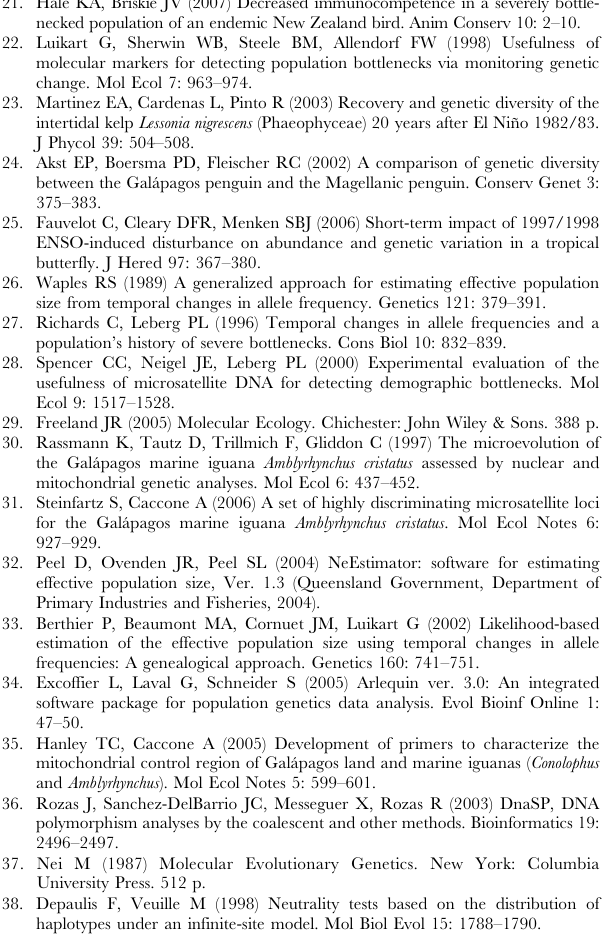
Table S4 List of nucleotide diversity ( p ) values and their variance (V) for marine iguana populations. List of nucleotide diversity ( p ) values and their variance (V) for marine iguana populations from both time points. T-values and their corre- sponding probabilities are based on the test adapted by Nei [37] and reflect whether p values are significantly different between time points. Positive t values reflect a decrease in p from the first to the second sampling, while negative t values reflect an increase.